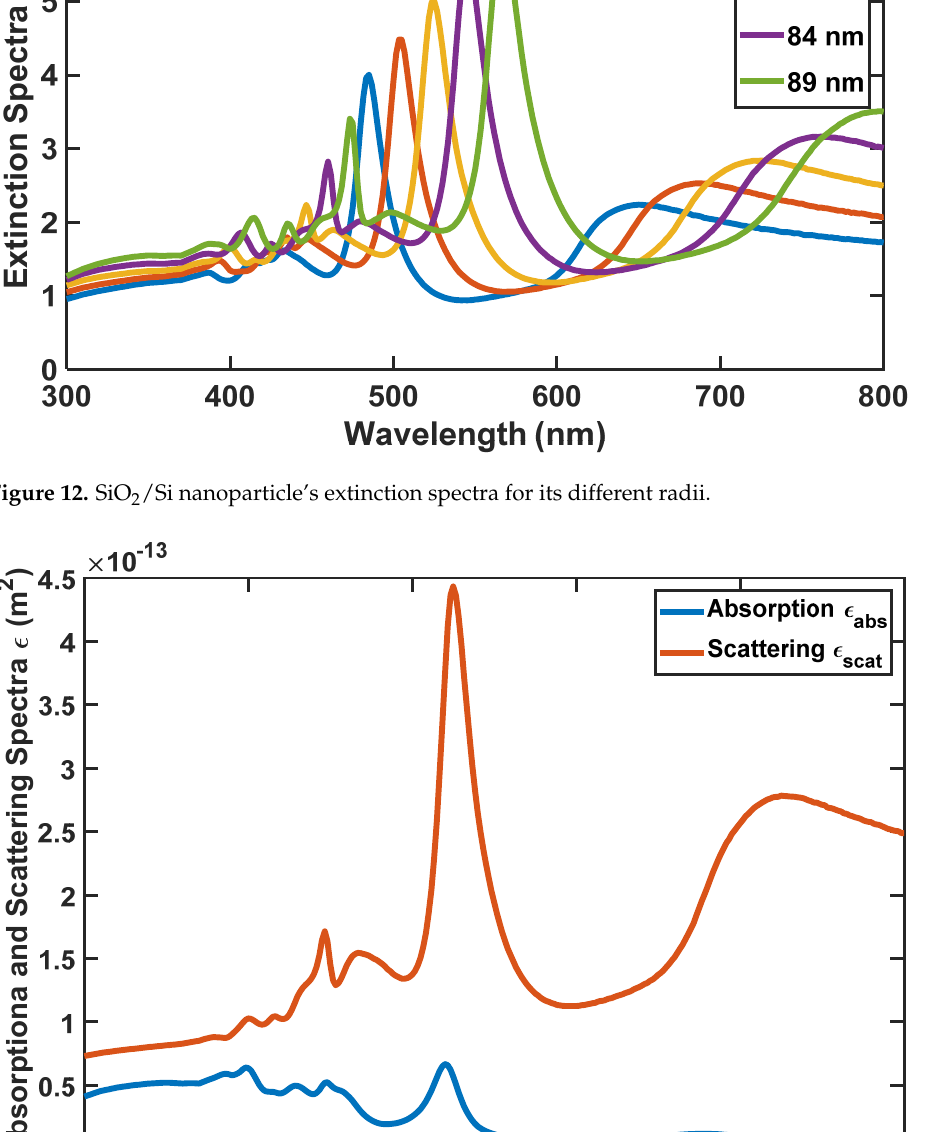
2 /Si nanoparticle with R = 85